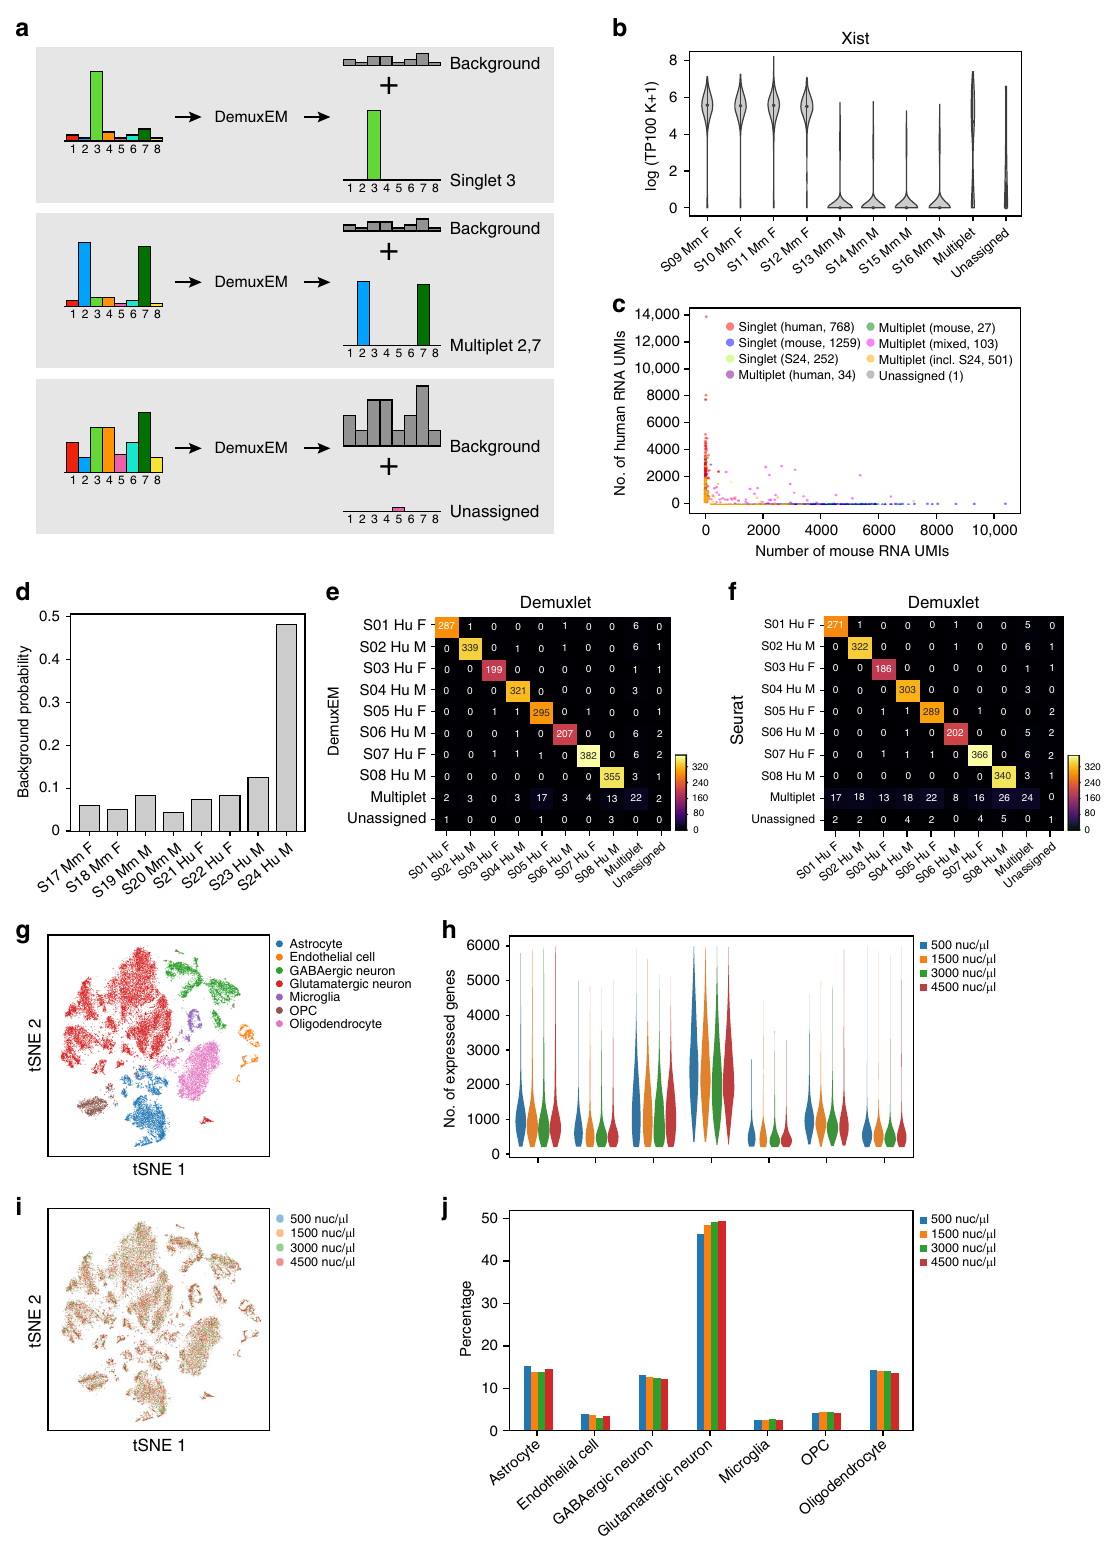
multiplets (Fig. 2c, green (mouse) and purple (human)) and off- axes for inter-species multiplets (Fig. 2c, fuchsia). Notably, DemuxEM ’ s assignments were robust to changes in the de fi nition of background distribution, Dirichlet prior concentration para- meter on the samples, and sequencing depth (Supplementary Fig. 3 and